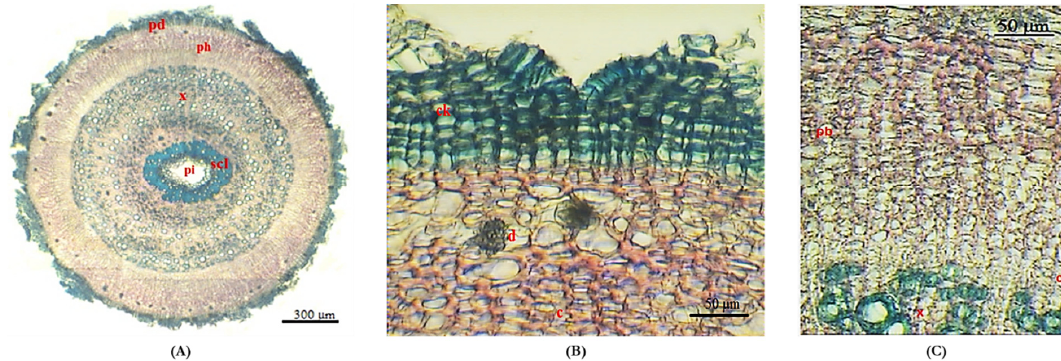
Figure 2. Cross section of the root; (A) Ensemble; (B) Portion with cork and cortex; (C) Portion of the stele